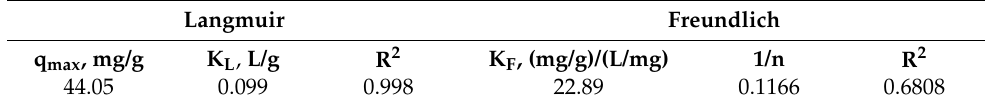
Table 1. The parameters of adsorption isotherms of Cd (II) ions.